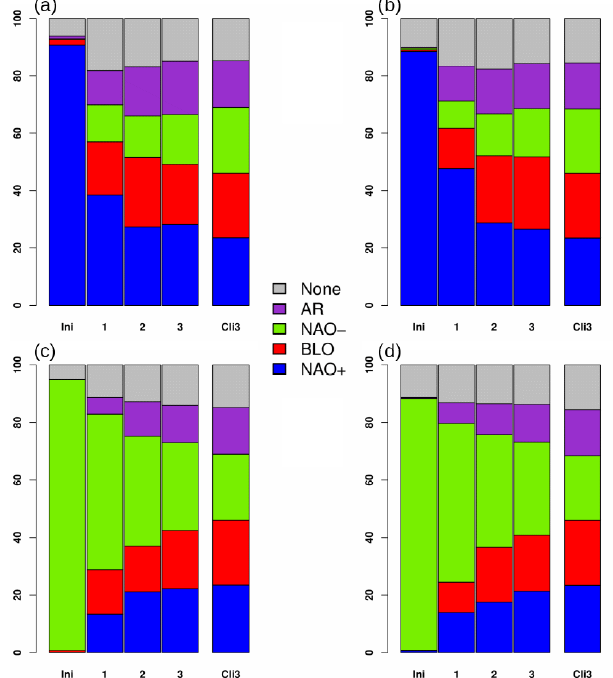
Figure B2. Like Fig. 6 but with a fifth category “none” including days outside any persistent sequence of a canonical weather regime.